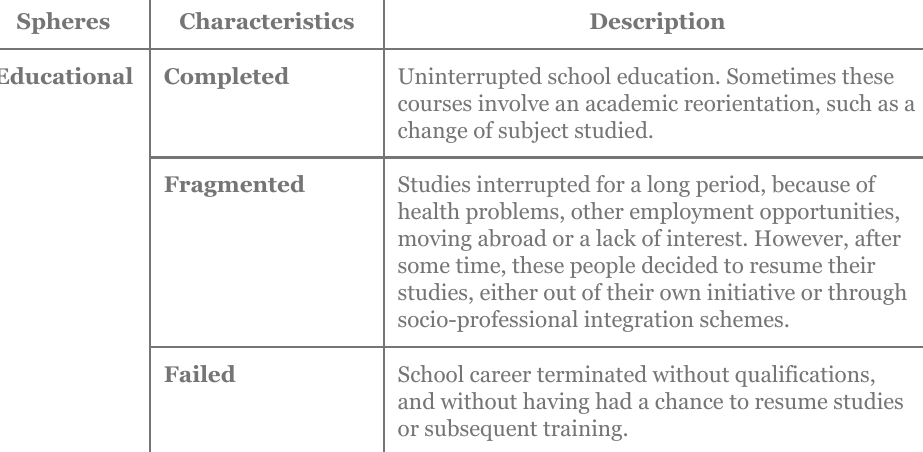
Table 1: Overview of the life trajectories in the educational, professional and private